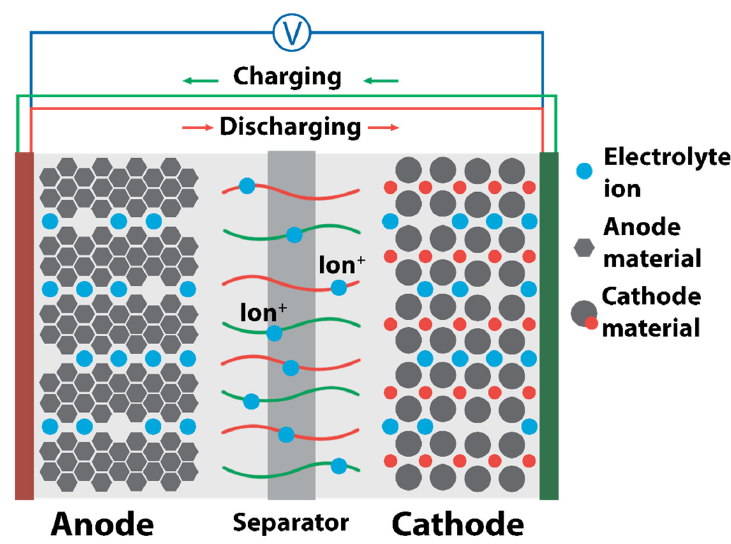
Figure 7. Schematic illustration of organic polymer-based battery.